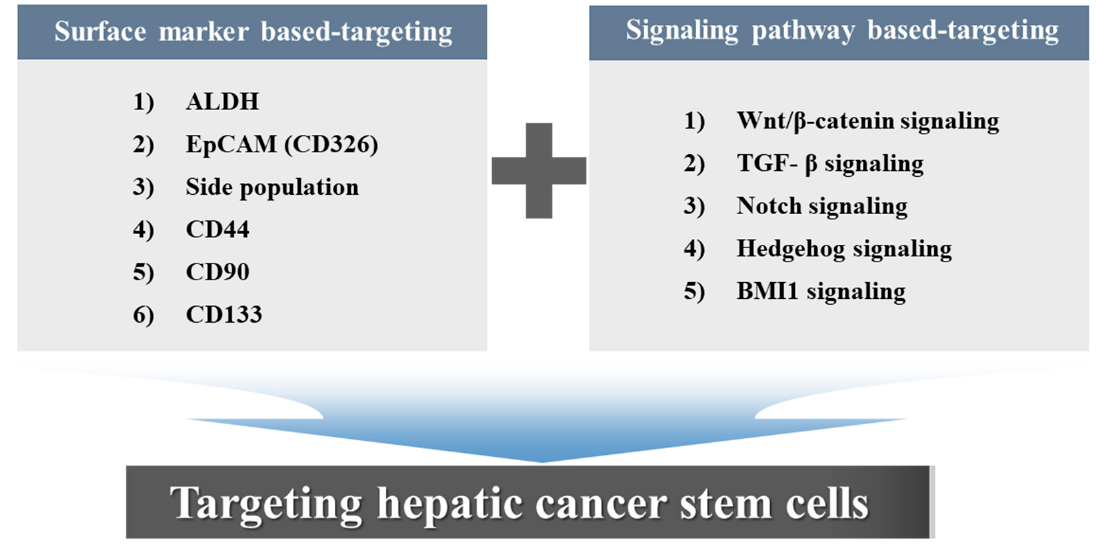
Figure 3. Schematic diagram summarizing the potential roles of stem cell-related markers or signaling pathways targeting hepatic cancer stem cells. Selectively targeting specific stem cell-related markers (aldehyde dehydrogenase (ALDH), EpCAM, side population, CD44, CD90, and CD133) and / or -signaling pathways (Wnt / β -catenin, TGF- β , Notch, Hedgehog, and BMI1 signaling) of hepatic CSCs is an effective therapeutic strategy for treating chemotherapy-resistant liver cancer.